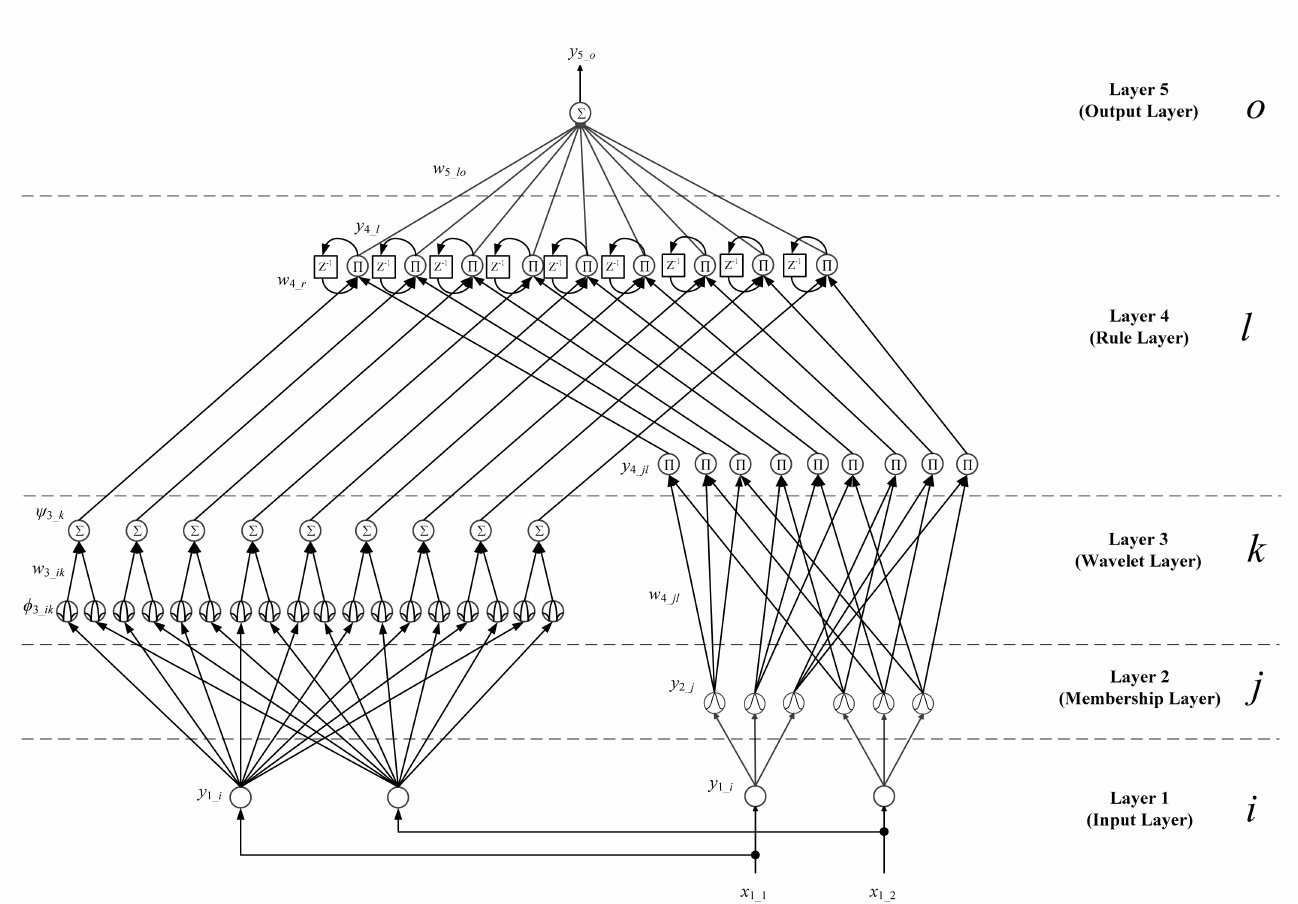
Figure 2. Structure of RWFNN